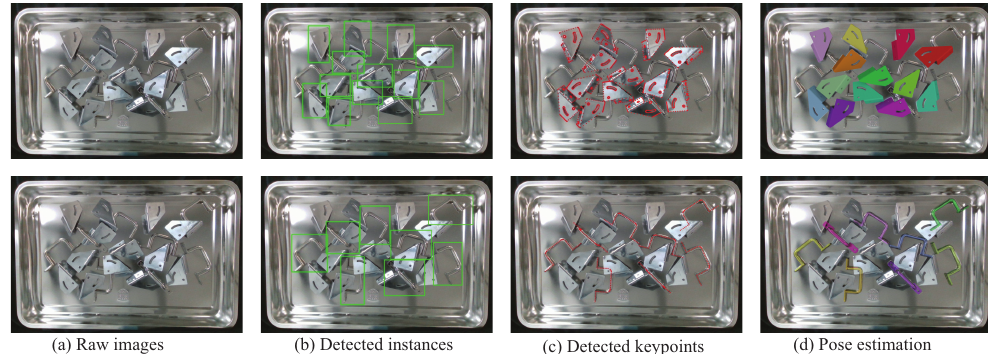
Figure 8. Pose estimation process: the first column images are the raw images, the second column images are the detected shiny industrial parts marked with the green bounding box, the third column images are corresponding predicted keypoints marked with red dots, the last column images are the 3D model with estimated poses overlaid in a specified